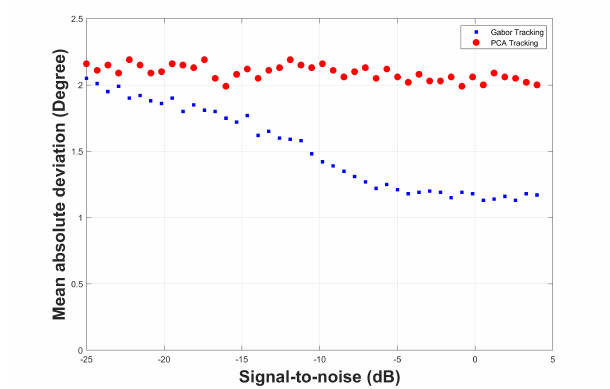
Figure 10. Example of Evaluation Experiments.